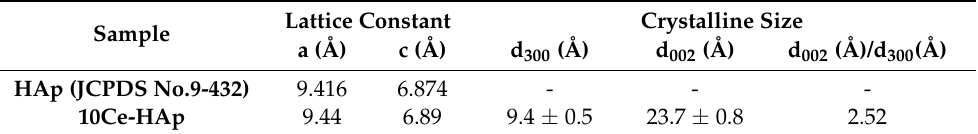
Figure 3. XRD patterns of the 10Ce-HAp in black and of pure hydroxyapatite (JCPDS no. 09-0432) in red ( a ); energy- dispersive X-ray spectroscopy (EDS) analysis of 10Ce-HAp ( b ) and SEM image ( c ). Table 1. Lattice constant and crystalline sizes calculated from the XRD patterns of the synthesized 10Ce-HAp